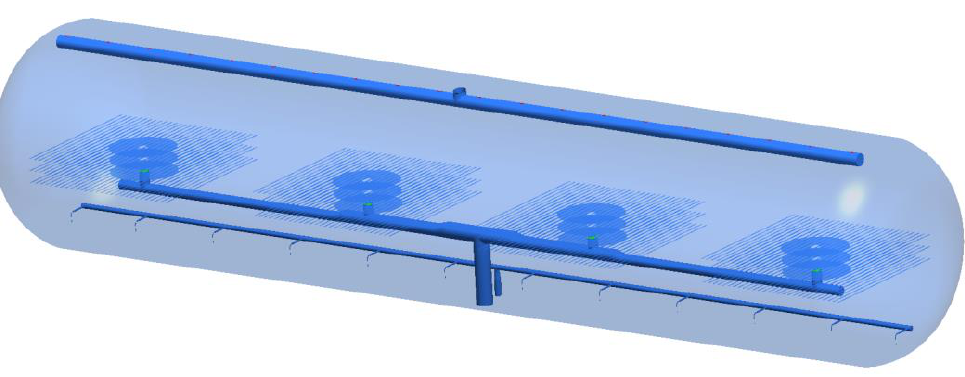
Figure 1. Schematic of the desalting unit used in this study.